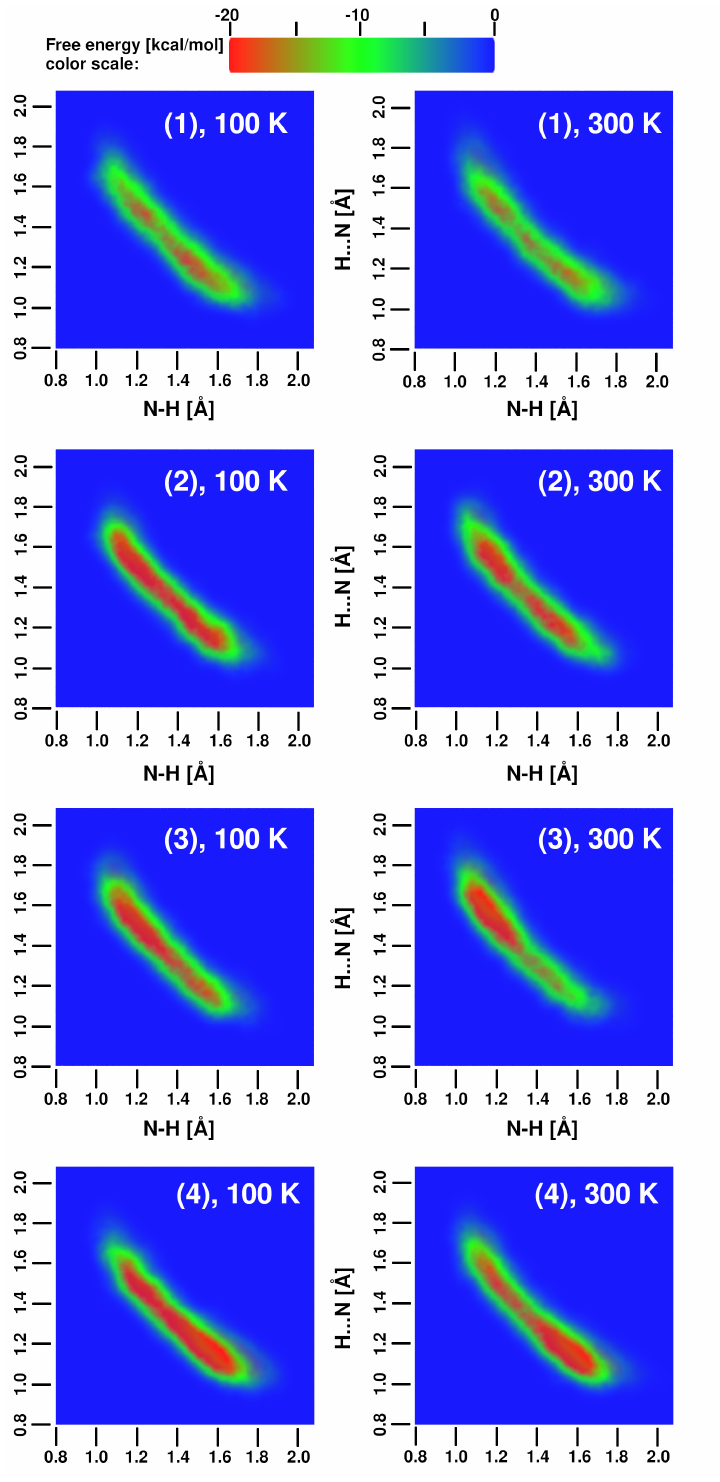
Figure 9. Free energy surface for proton motion in the compounds (1)–(4). Two-dimensional slices across the three-dimensional volumetric data resulting from the CPMD-based gas phase metadynam- ics. The N · · · N value for the slice is 2.6